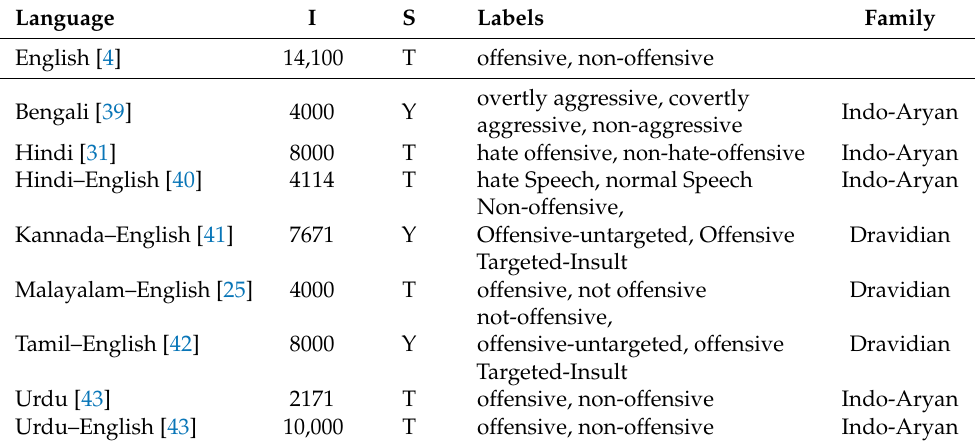
Table 1. Instances (Inst.), source (S), and labels in all datasets. T stands for Twitter and Y for Youtube. In the Kannada and Tamil datasets, the label “Offensive Target-Insult” is further subdivided into the OLID level C